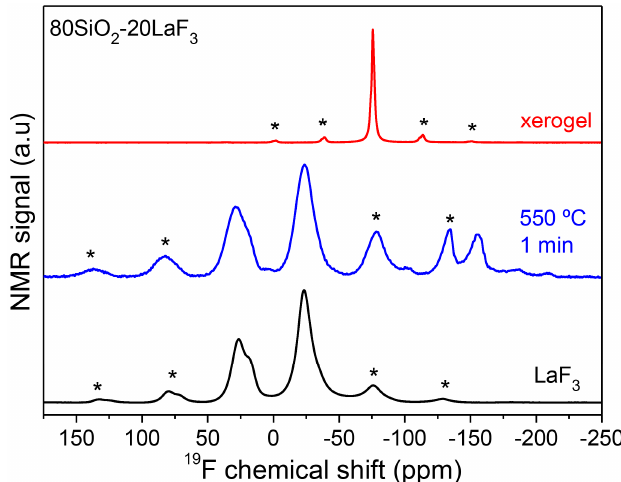
Figure 11. 19 F MAS-NMR spectra of 80SiO 2 -20LaF 3 xerogel and GC treated at 550 °C for 1 min. The spectrum of pure LaF 3 crystal powder is also given for comparison. Stars indicate spinning sidebands.